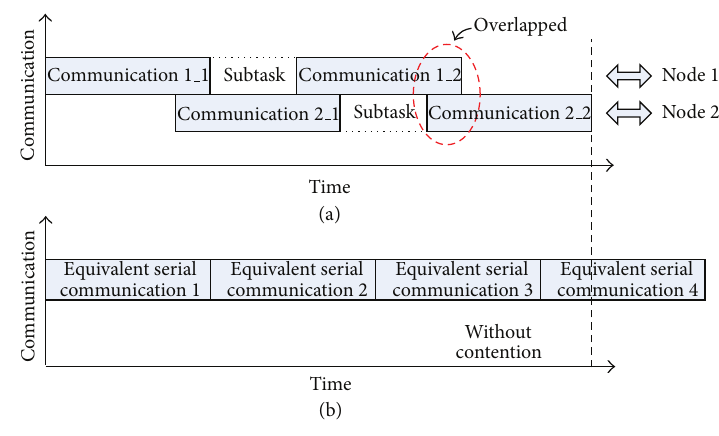
Figure 4: Communications in the entire